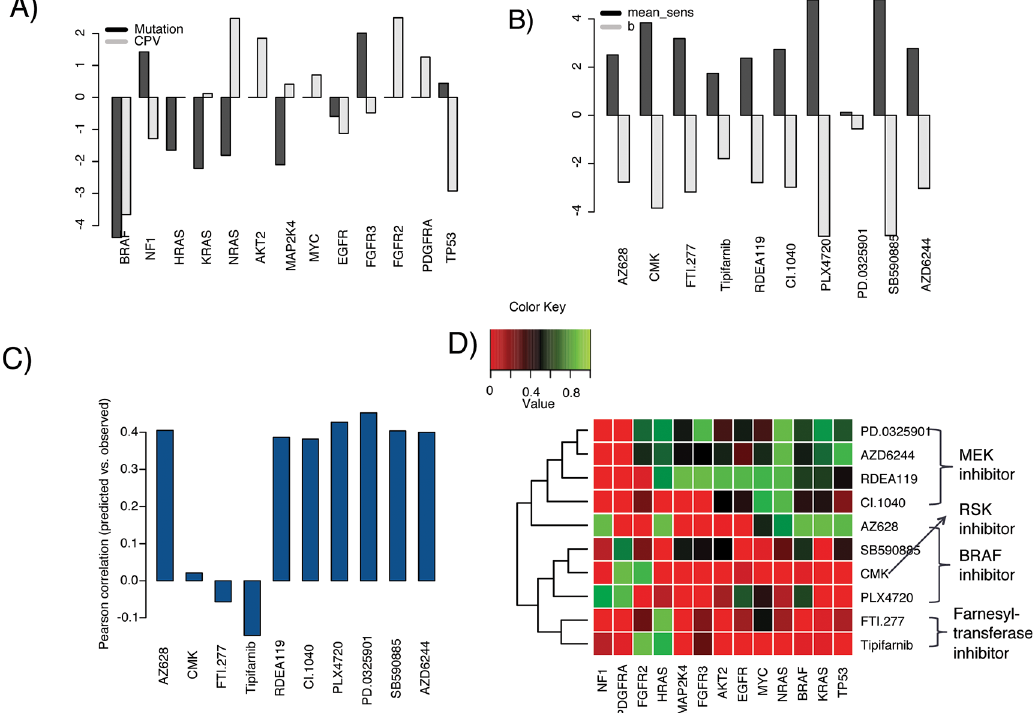
Fig 3. Prediction results of the network-flow model. A) Contributions of different genetic alterations (mutation and copy number variance) to the MAPK pathway activity; B) Predicted residue b is consistent with the mean drug sensitivities (IC50); C) Pearson correlation coefficients between predicted and real MAPK drug sensitivities; D) Predicted drug effects of 10 MAPK drugs to 13 cancer-related